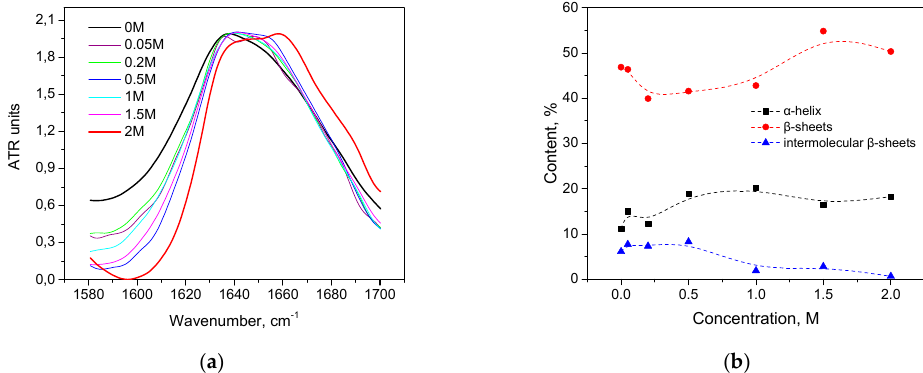
Figure 10. Changes in the character of the Amide I band ( a ) of trypsin at 23 °C with various concentrations of (NH 4 ) 2 SO 4 and ammonium sulfate-induced conformational transition of trypsin at 23 °C ( b ). Protein concentration was 20% wt.